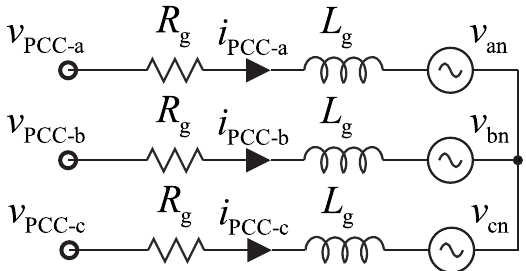
Figure 3. Circuit diagram of three-phase resistive–inductive